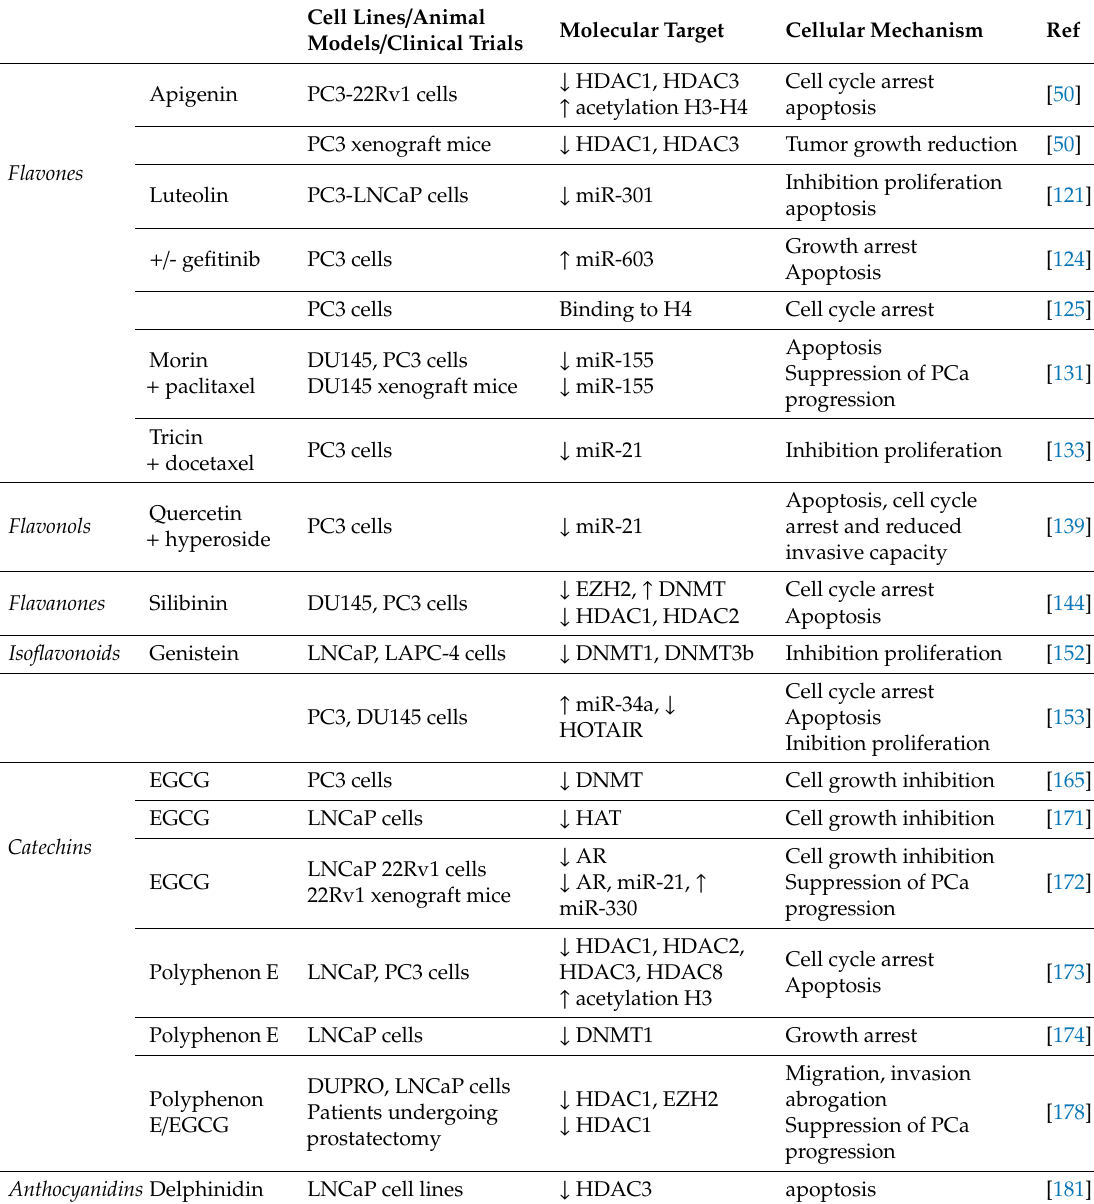
Table 2. Targets and cellular mechanism of flavonoids in prostate cancer (PCa). Flavonoids that exert anti-tumoral e ff ect in PCa through epigenetic mechanisms are reported in the table. See text for